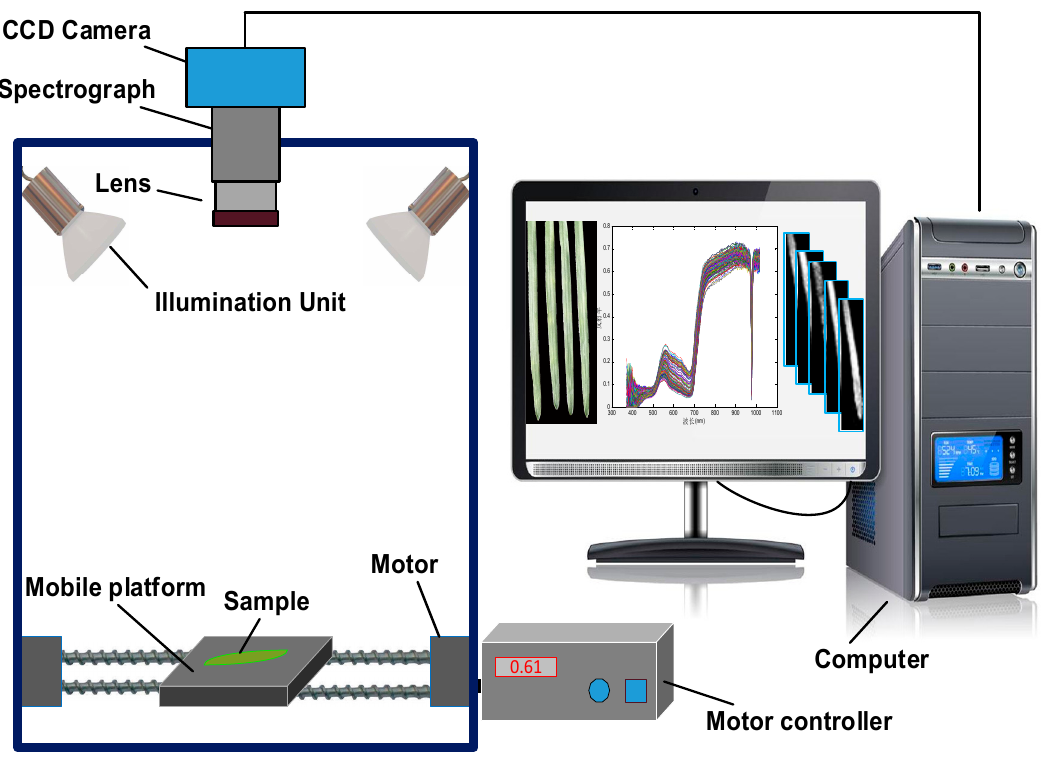
Figure 1. The schematic diagram of the hyperspectral imaging system.